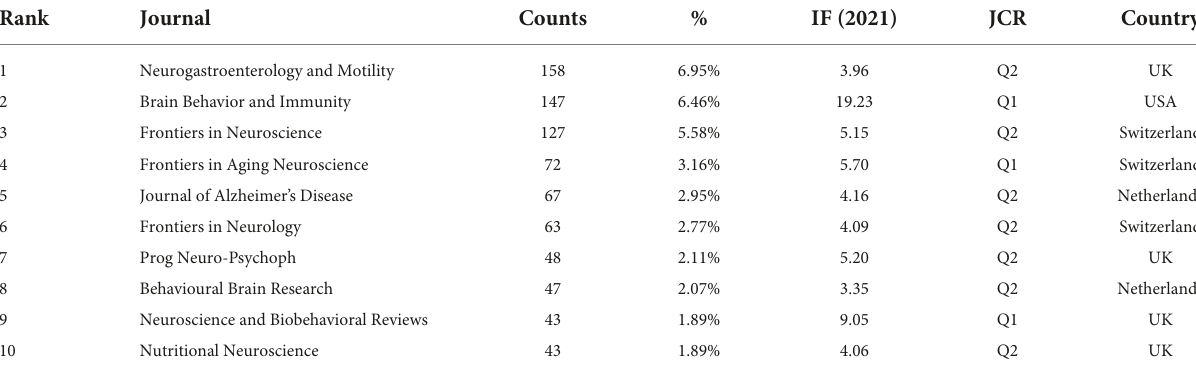
TABLE 4 The top 10 journals publishing articles in the gastrointestinal microbiome and